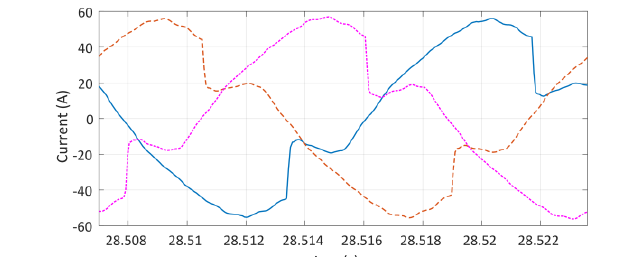
Fig. 9. Waveform in 𝑀 1 with 𝑇𝐻𝐷 𝑖 - 𝑆 𝐺 + 𝑁 𝐿 connected. Table XII. Values in 𝑀 1 with 𝑇𝐻𝐷 𝑖 - 𝑆 𝐺 + 𝑁 𝐿 connected. 𝑇𝐻𝐷